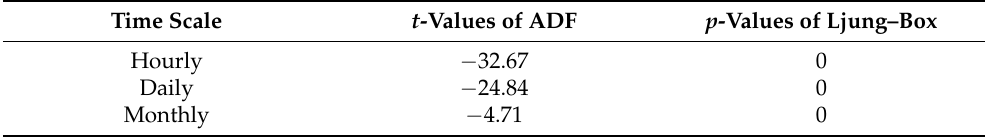
Table 1. ADF test and Ljung–Box test of the EDH time series at different timescales. The t-statistic values are − 3.45, − 2.87 and − 2.57 for 1%, 5%, and 10% significance level, respectively. Time Scale t -Values of ADF p -Values of Ljung–Box Hourly − 32.67 0 Daily − 24.84 Monthly −